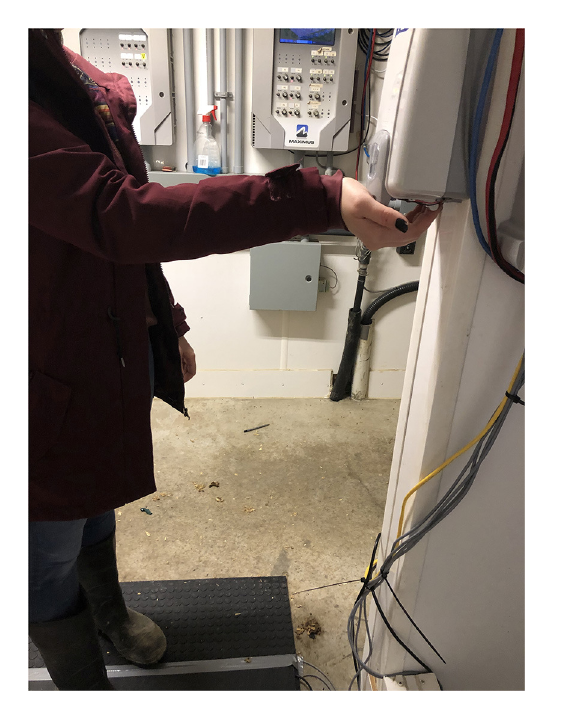
FIGURE7 Clean area of the turkey barn (pressure mat and antenna located on the floor connected to the hand sanitizer device)—Maximus